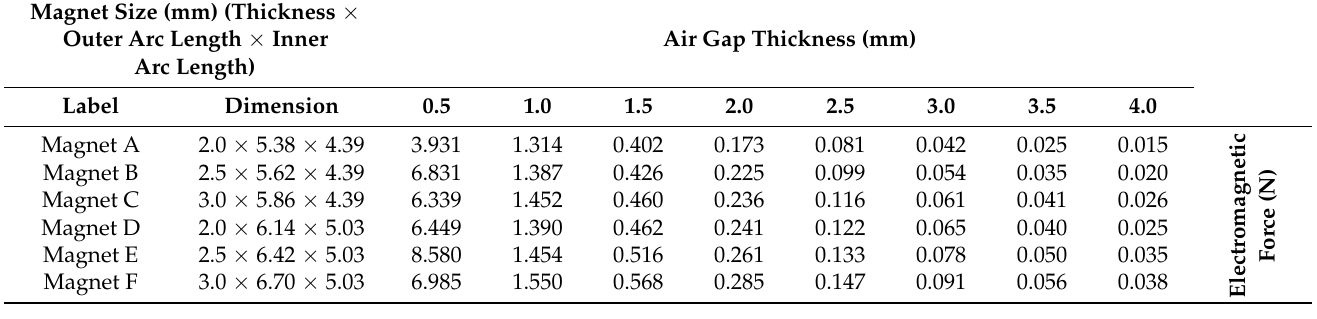
Table 2. Electromagnetic force by magnet dimensions for square edge stator.